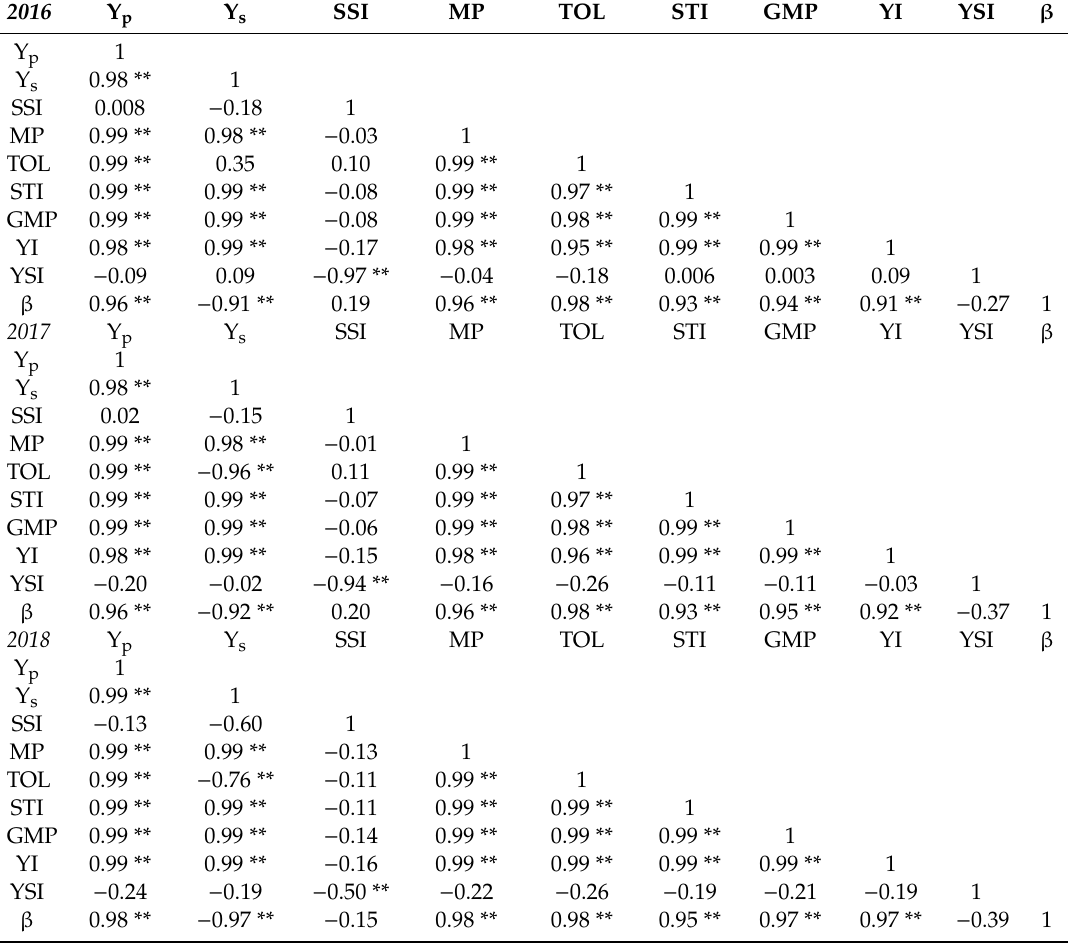
Table 5. Simple correlation coe ffi cients between Y p , Y s , and drought tolerance / susceptibility indices of genotypes in Jiroft in three years.